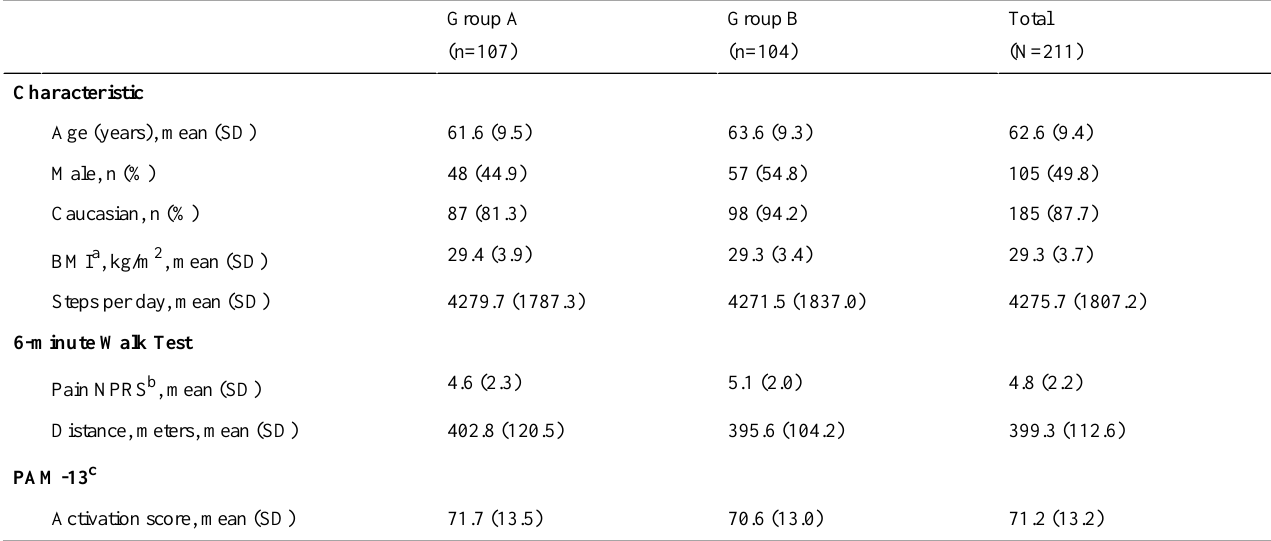
Table 1. Patient demographics and baseline characteristics.